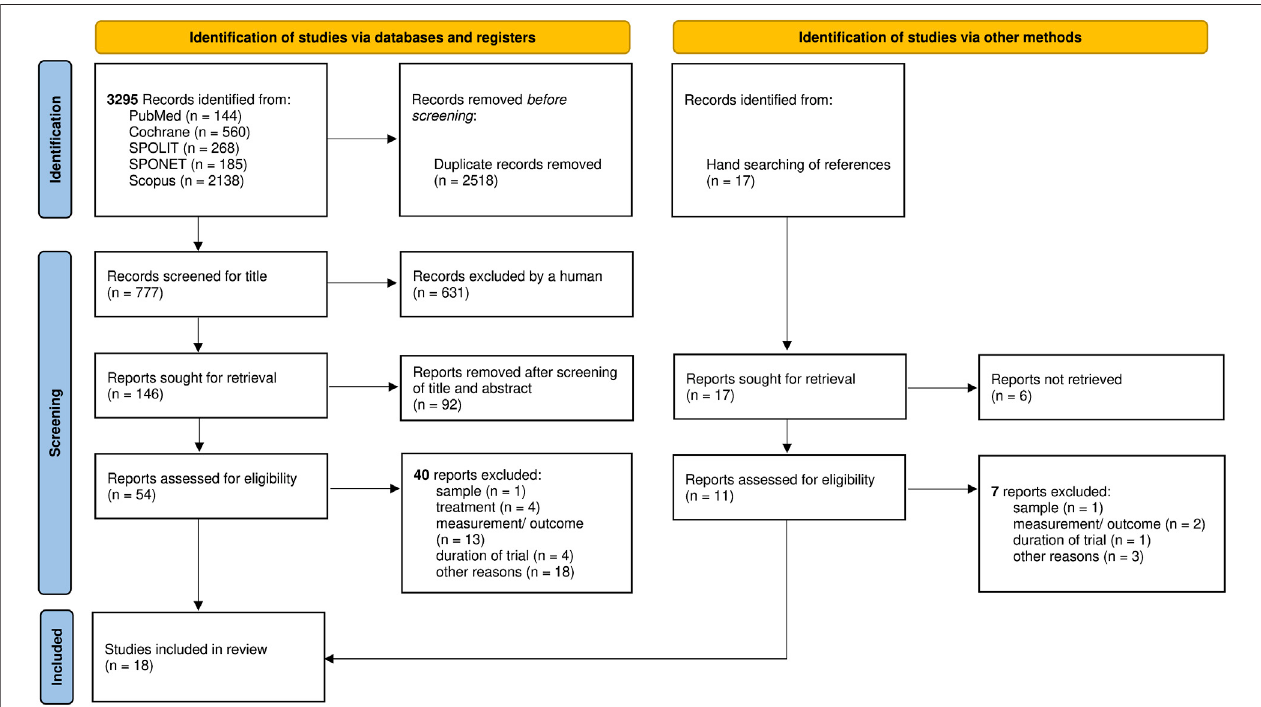
FIGURE 1 | Flow diagram of selection